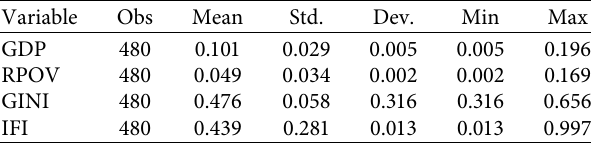
Table 1: Descriptive statistics of